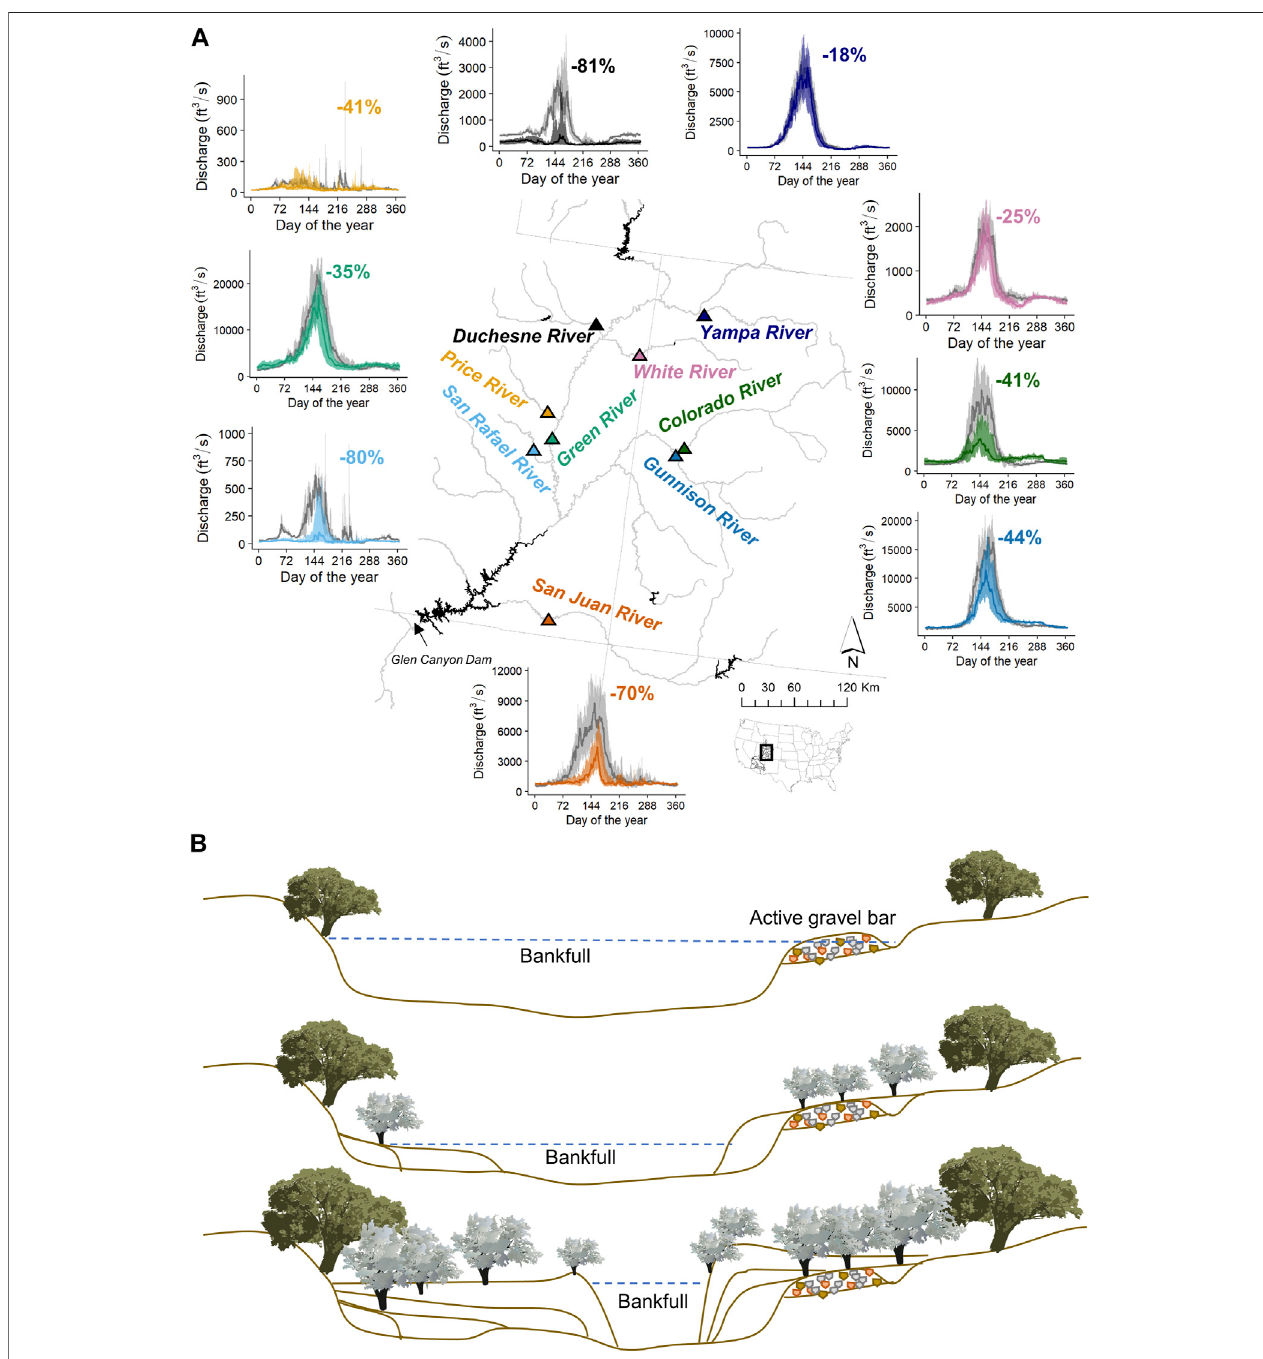
FIGURE 1 | (A) Flow regimes of mainstem and major tributary rivers in the upper Colorado River basin (upstream of Glen Canyon Dam). Historical fl ows (1929 – 1949) are in grey and present fl ows (2000 – 2021) are in color. Lighter bands represent 25th and 75th percentiles and bold lines represent 50th